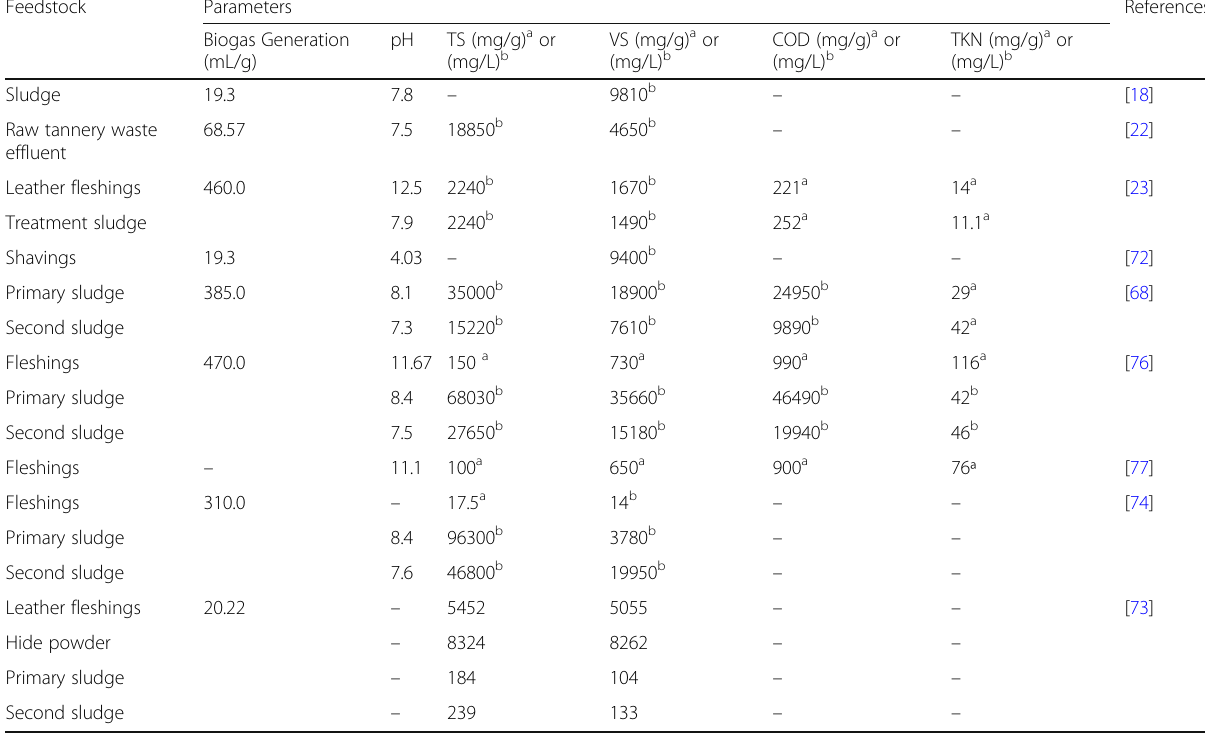
Table 6 Main parameter analyzed to obtain biogas